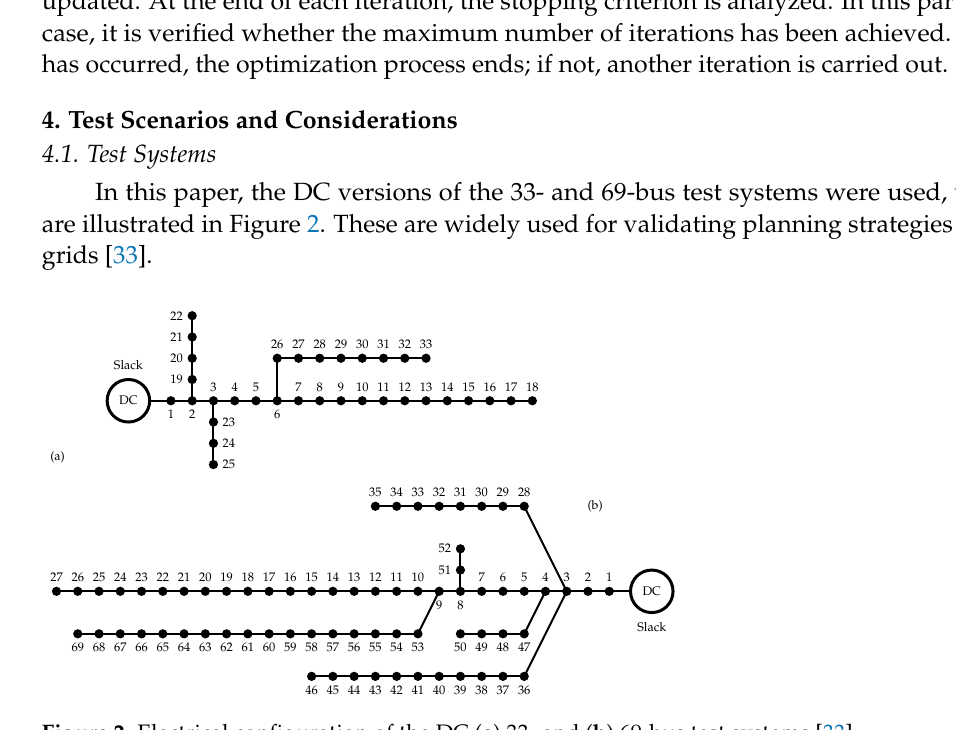
Figure 2. Electrical configuration of the DC ( a ) 33- and ( b ) 69-bus test systems